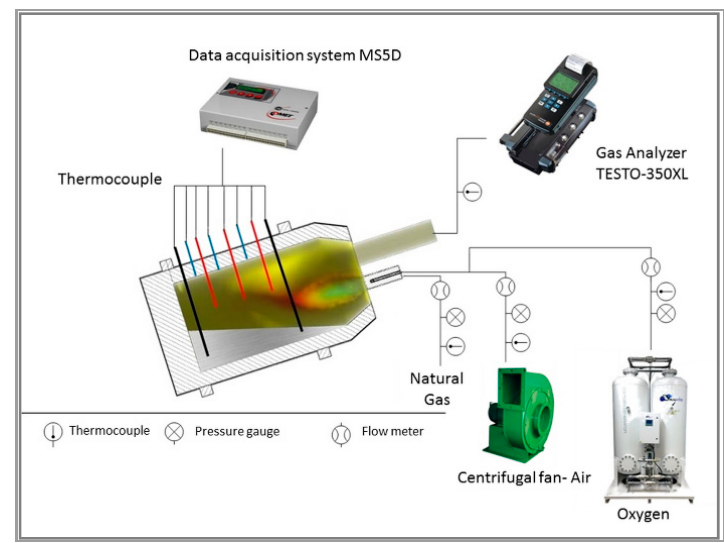
Figure 2. A schematic diagram of the experimental device.